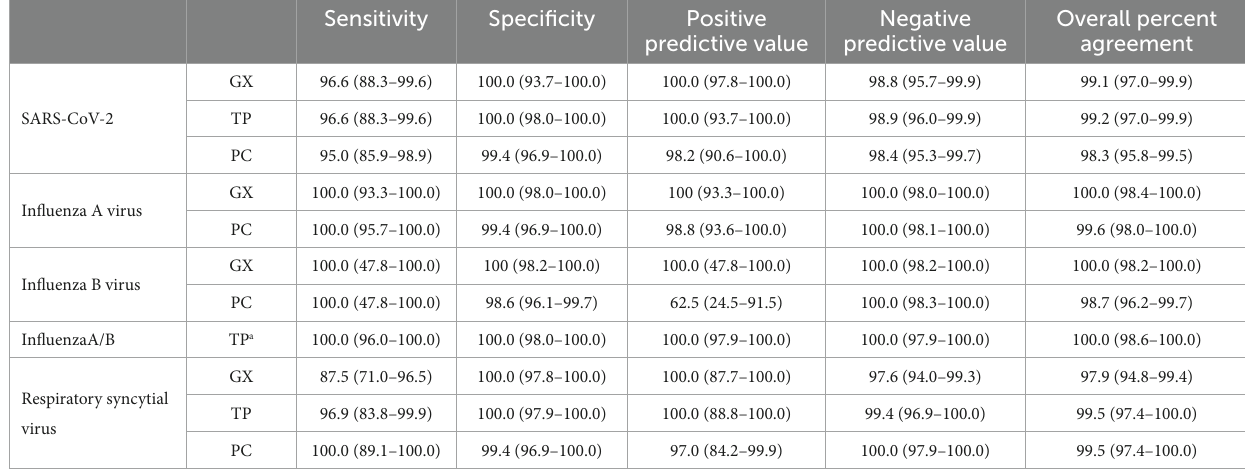
TABLE 3 Comparison of evaluated assay and standard WHO/GIRS assays currently used in the laboratory.